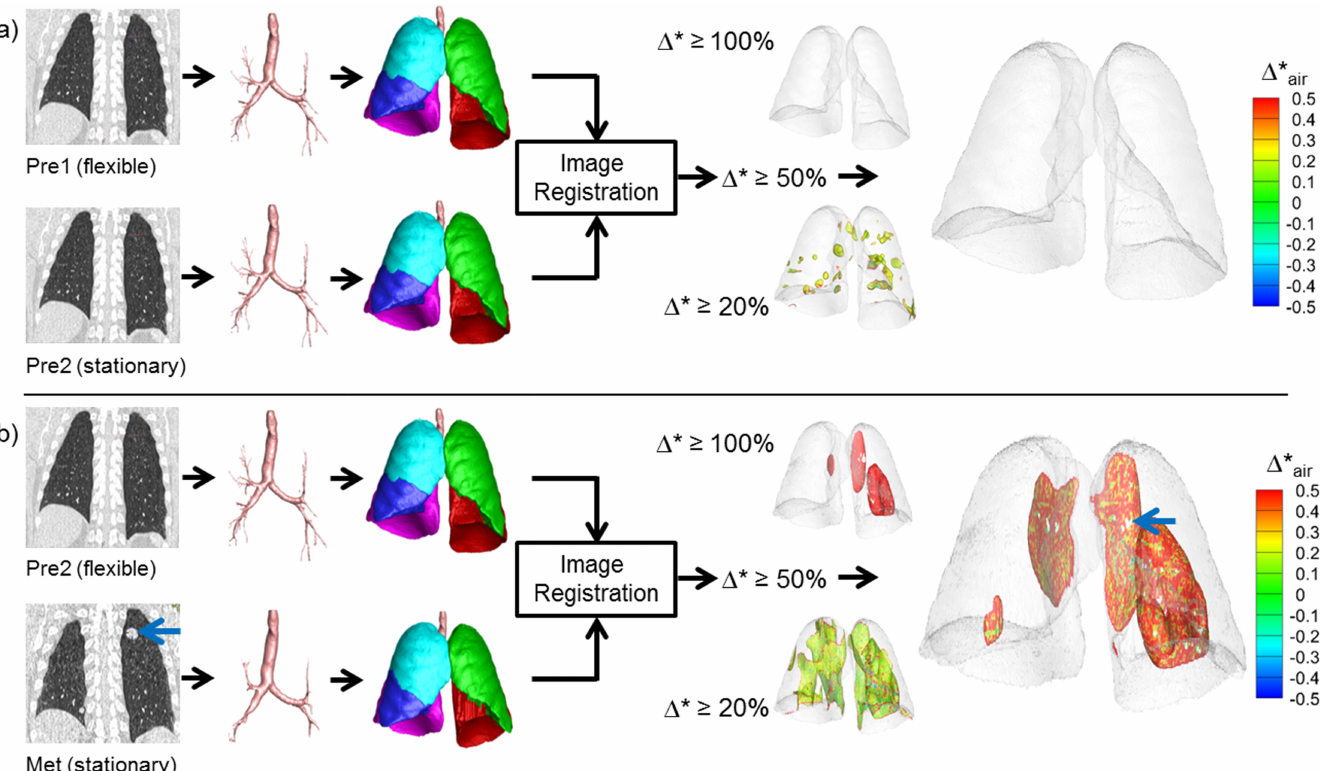
Fig 4. Regional hyper-expansion signals in serial CT pairs of a sarcomapatient (Group 3) with lung metastasis. (a) Pre1 and Pre2 and (b) Pre2 to Met. Lung metastases were not found at two earliertime points Pre1 and Pre2. A large metastatic nodulewas noted on the 3rd scan, Met, indicatedby the blue